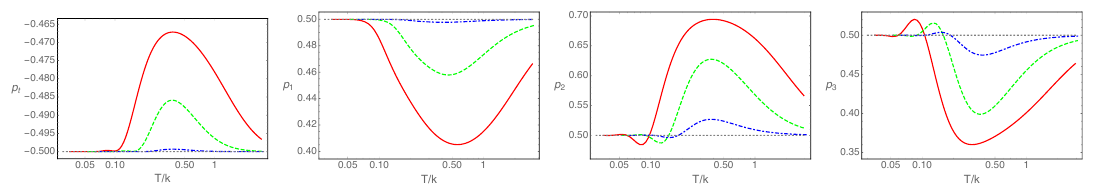
Figure 3 . The Kasner exponents as a function of T/k for α b = 1 (red), 0 . 5 (green), 0 . 1 (blue). The gray dotted line is for Schwarzschild black hole with p t = − 0 . 5 = − p 1 = − p 2 = − p 3 .